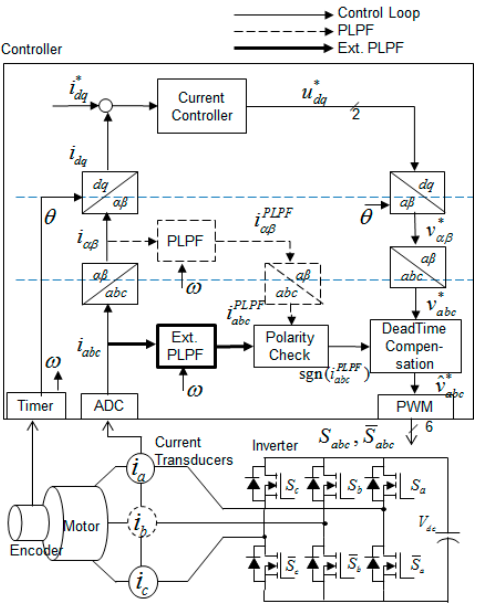
Figure 10. Comparison of signal flows between conventional PLPF and extended PLPF for dead-time compensation.